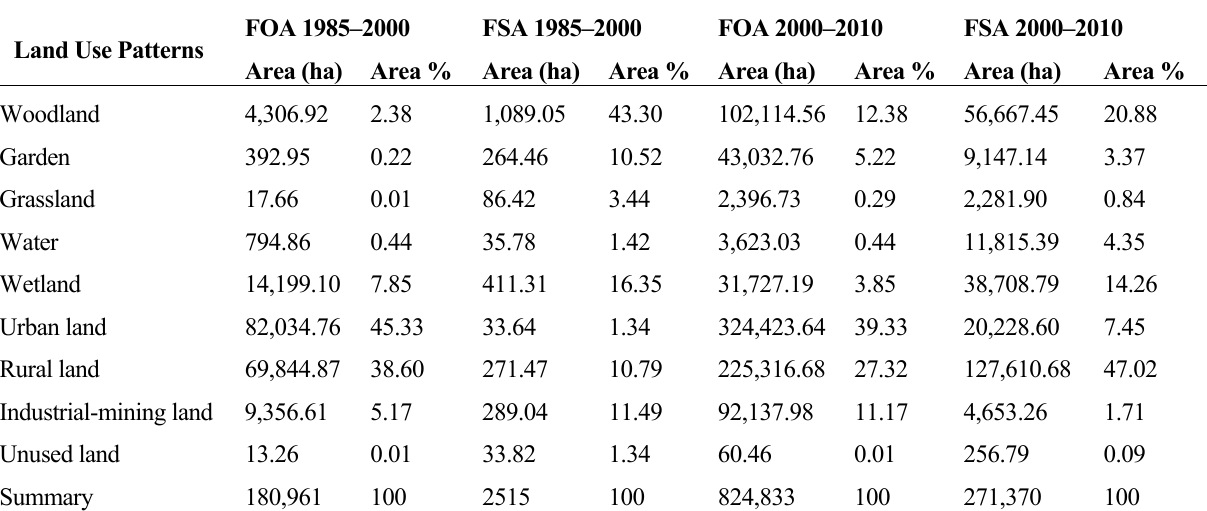
Table 3. The AFOS transformation